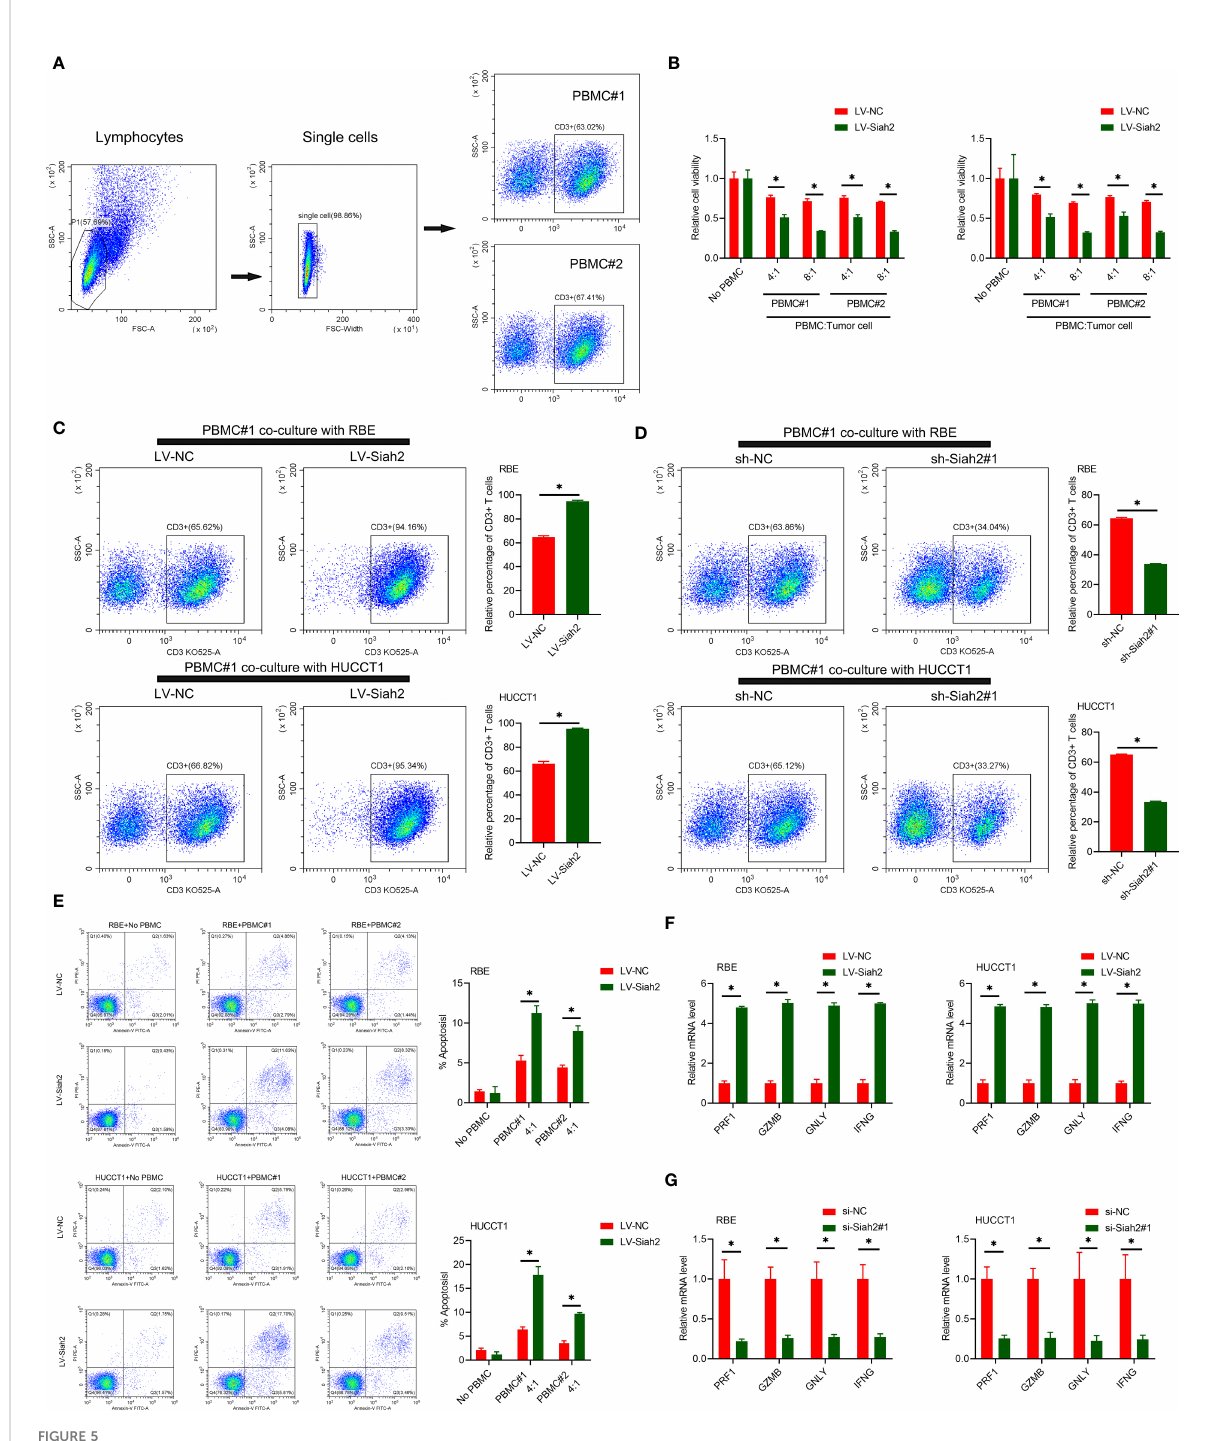
FIGURE 5 Siah2 enhanced in vitro antitumor T-cell activity. (A) , Gating strategy and T cell percentage of activated PBMC. (B) , CCK8 assay detected the killing of tumor cells by activated HPBMC. CCA cells were co-cultured in the presence or absence of HPBMC for 24 h. Data were normalized to their respective no HPBMC controls. (C, D) , Activated HPBMC (#1, #2) were co-cultured with LV-NC/LV-Siah2 (C) or sh-NC/sh-Siah2 (D) for three days at the ratio of HPBMC to tumor cell number of 4 to 1. The percentage of CD3 in HPBMC was determined by FCM. Representative plots of CD3+ T cells are shown. Data were normalized to the control group. (E) , Activated HPBMC (#1, #2) were co-cultured with CCA with LV-NC/LV-Siah2 cells for 24 h at the ratio of HPBMC to tumor cell number of 4 to 1. HPBMC were collected and stained with PE-Annexin V and subjected to FCM analysis. The percentage of apoptotic cells was analyzed. (F, G) , Quantitative RT-PCR was performed to detect PRF1 (perforin- 1), GZMB (granzyme), GNLY (granulysin), and IFNG (IFN-g) in activated HPBMC co-cultured with CCA cells with LV-NC/LV-Siah2 (G) for the indicated time or with si-NC/si-Siah2 cells for 48 h. The ratio of HPBMC to tumor cell number was 4 to 1. Mean ± SEM of three independent experiments. *P <